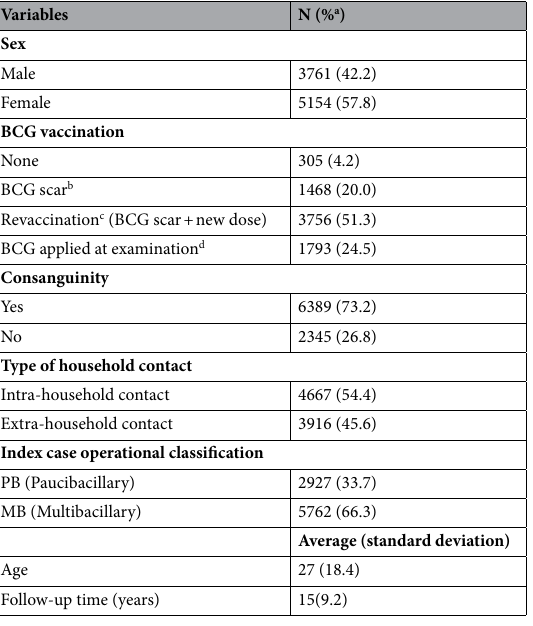
Table 1. Epidemiological profile of the cohort of contacts at the FIOCRUZ clinic, 1987–2018. a Proportions were calculated for valid data, excluding the respective missing data: n = 109 (1.2%) for sex, 1702 (18.9%) for BCG vaccination, 290 (3.2%) for consanguinity, 441 (4.9%) for intra/extra household and 335 (3.7%) for operational classification. b Only BCG scar. c Scar + new BCG vaccine dose applied at first examination. d BCG applied at first examination without previous